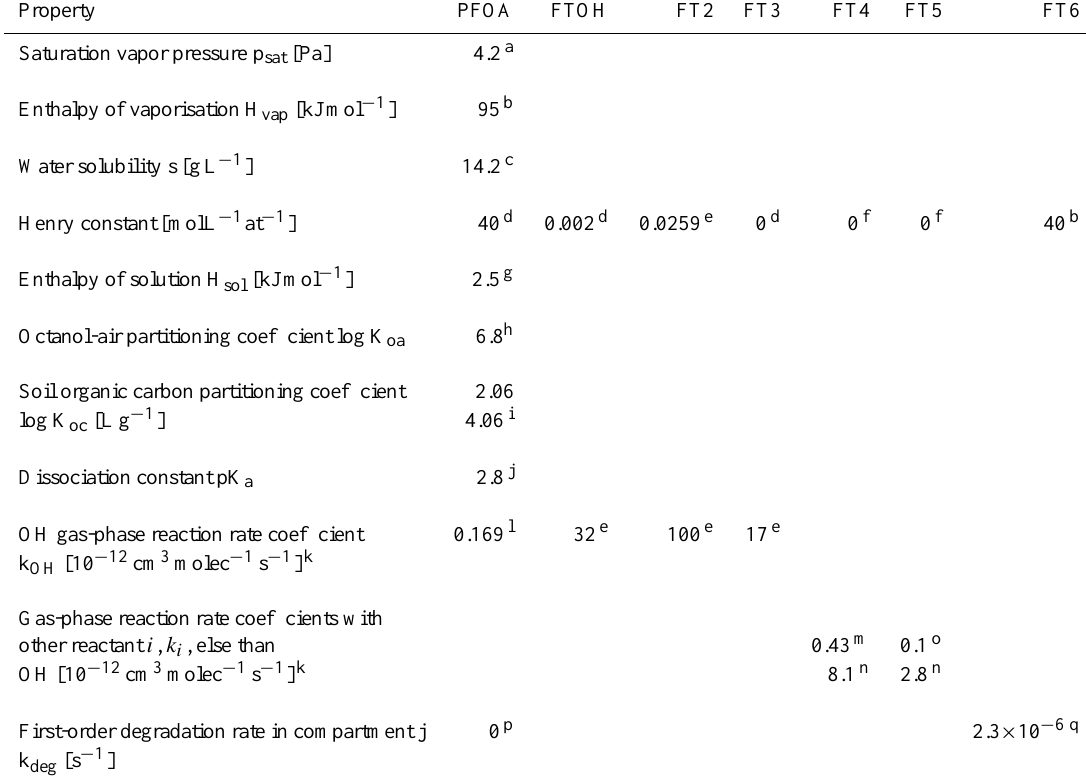
Table 1. Physico-chemical properties of PFOA and precursor substances. Data given for 298K unless